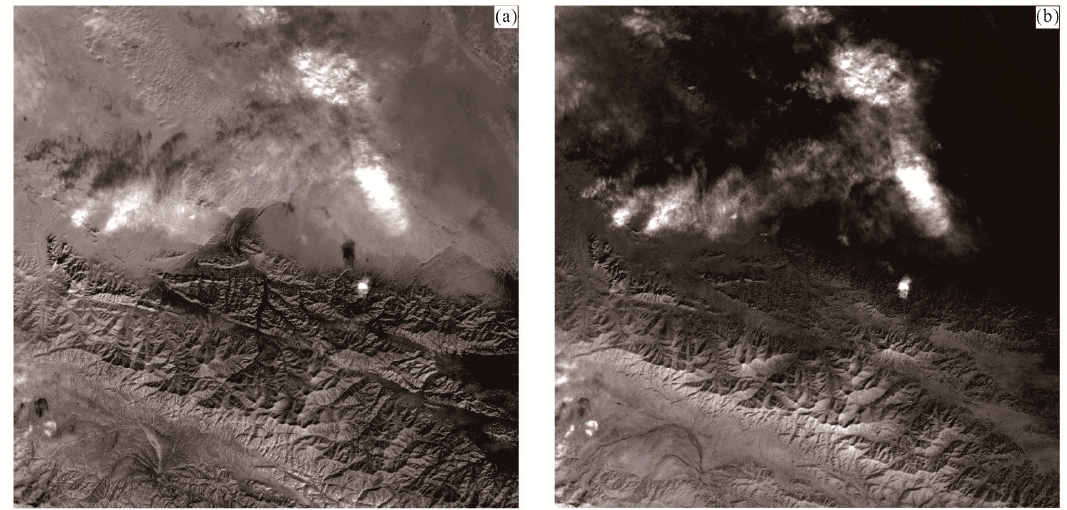
Figure 3. Results of the matched filtering (MF) method: ( a ) The MF result for ROI 1, and ( b ) the MF result for ROI 2.